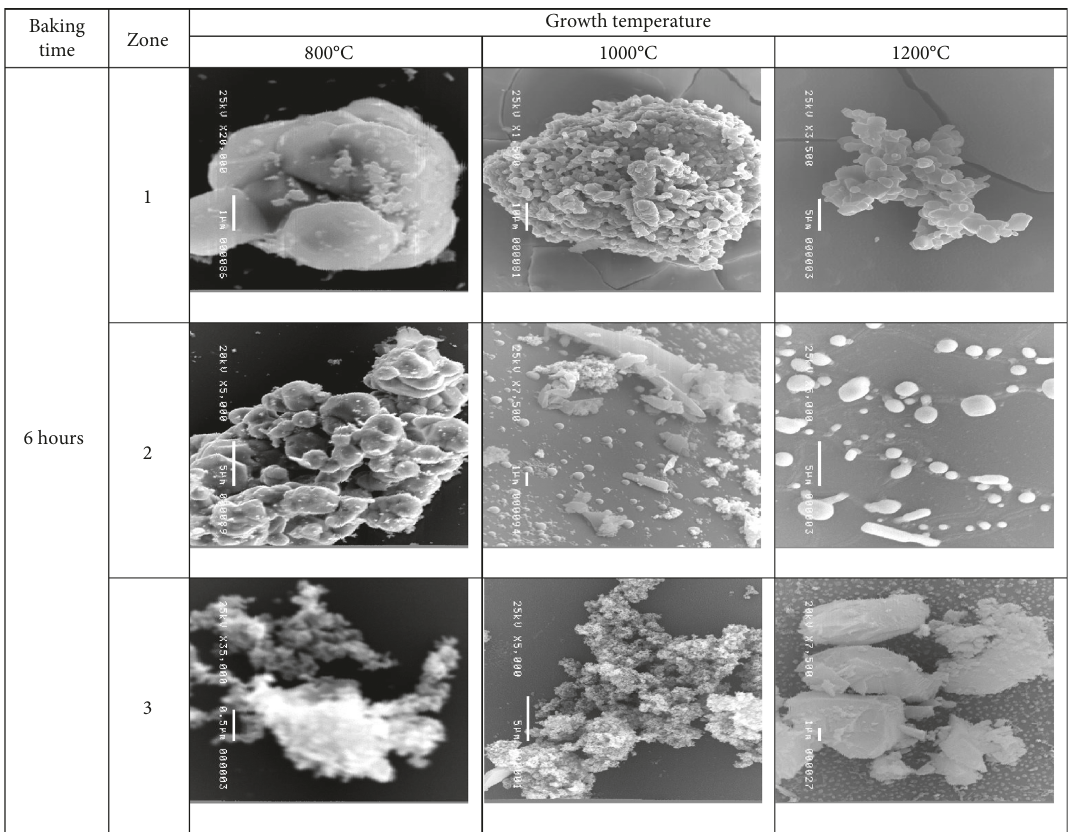
Figure 6: SEM image from 6 hours of baking